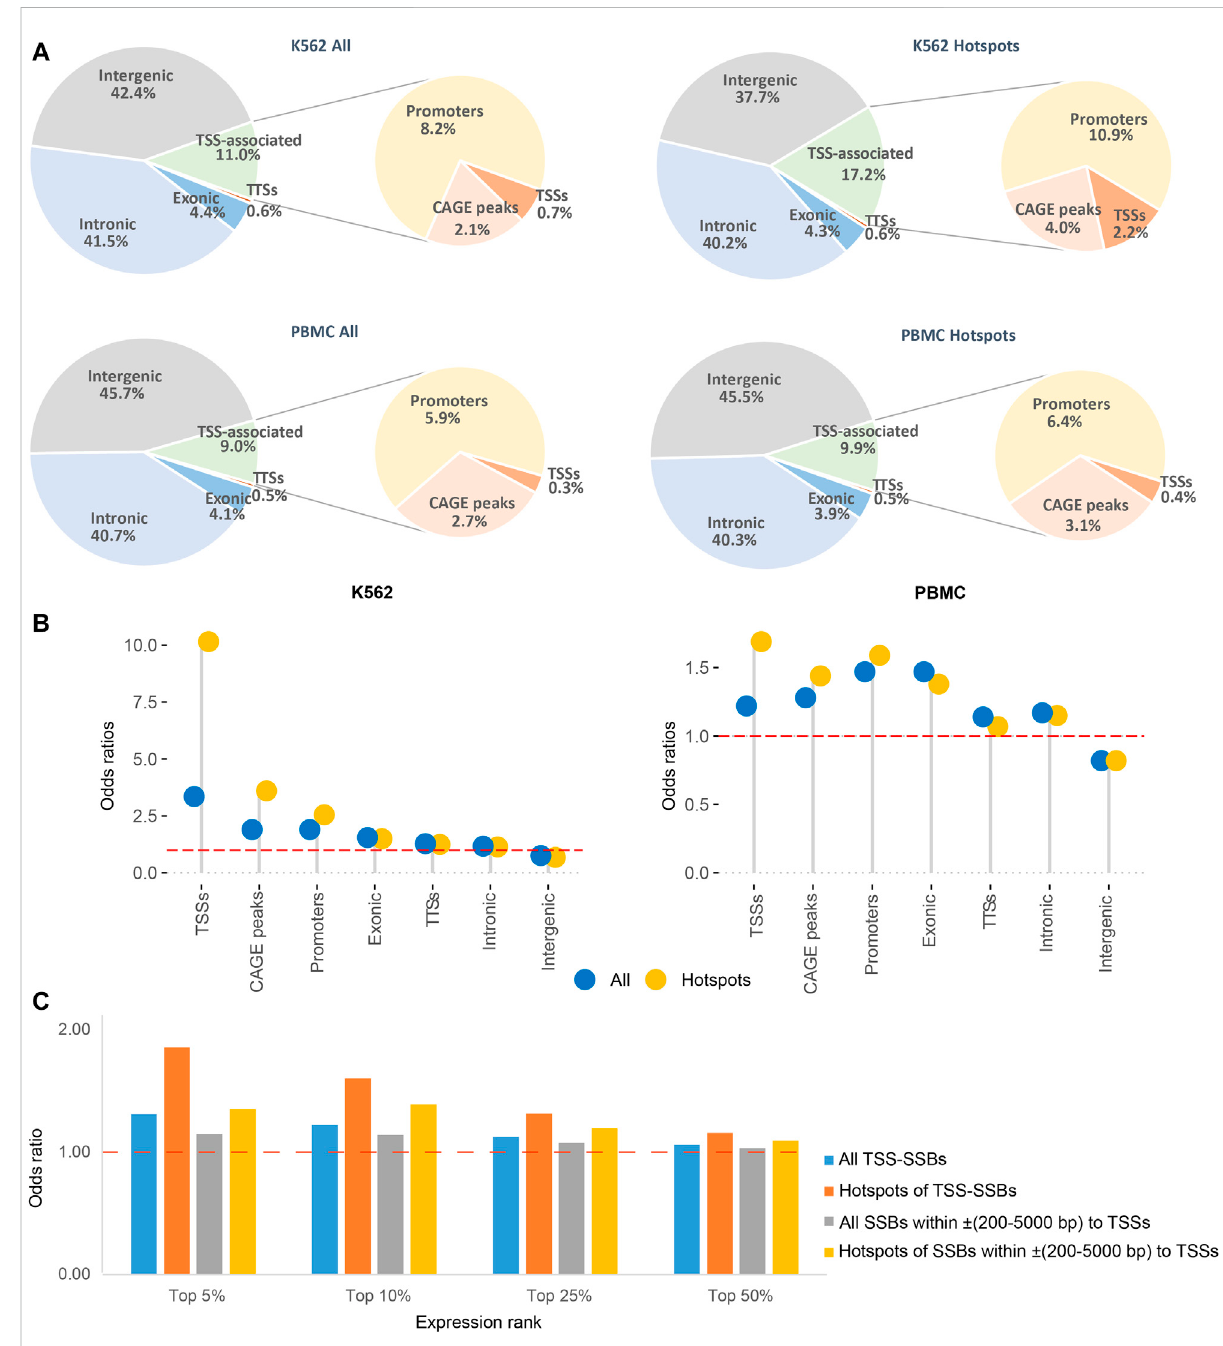
FIGURE 3 Distribution of all breaks and hotspots near TSSs and elsewhere in the genome. (A) Fractions of all breaks and hotspots mapping to within ±200 bp of TSSs, CAGE peaks or TTSs and inside promoters, exonic, intronic, or intergenic regions as described in Materials and Methods for K562(top)andPBMC(bottom). (B) Oddsratios(Y-axes) ofenrichmentofallbreaksandhotspotsinthedifferenttypesofgenomicelements(X-axes). The red dashedhorizontallines represent odds ratios of1 corresponding tono enrichment. See SupplementaryTable S3 for theexact numbers and the corresponding p -values, and Materials and Methods for more details. (C) The odds ratios of enrichment (Y-axes) of all SSBs or hotspots within ±200 bp or ±(200 – 5,000) bp oftheTSSs for top 5%, 10%, 25%and 50% expressedgenes compared to the randomly simulated data (Materials and